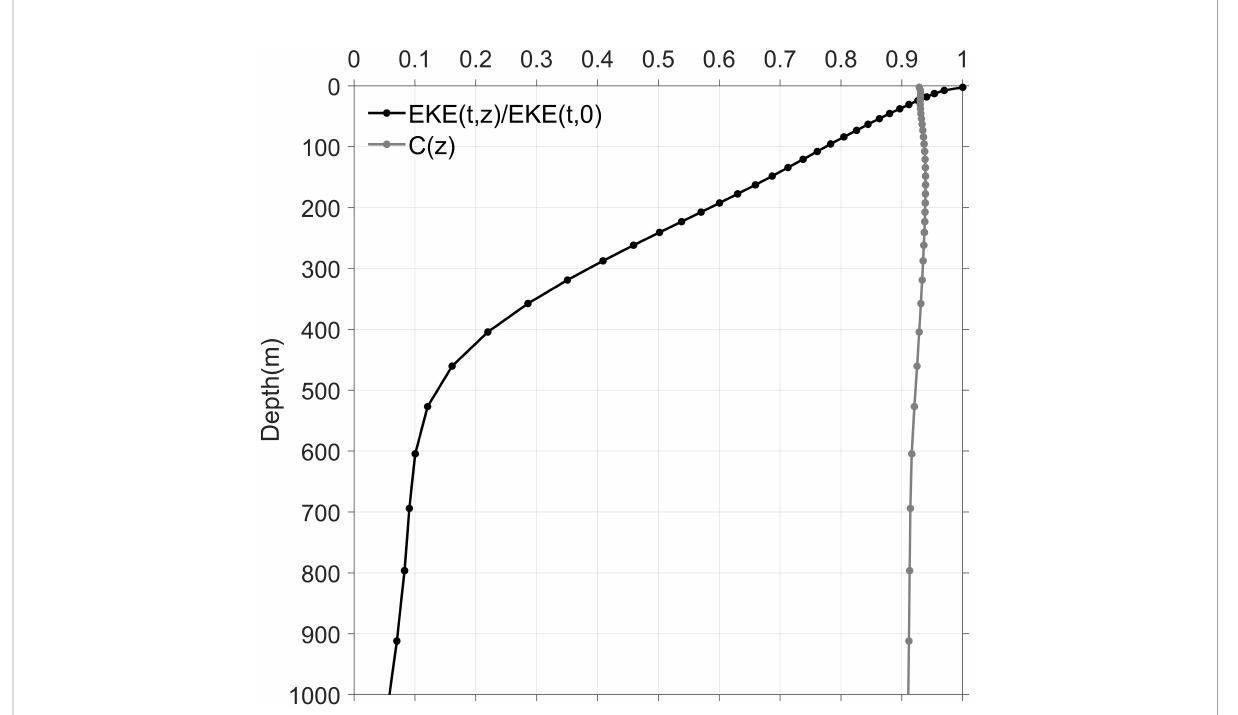
FIGURE 4 Black line: EKE averaged in 148°E-160°E, 30°S-45°S as a function of depth from OFES; the standardized EKE level as a function of depth: E ( t , z ) E Gray line: the EKE coherence level as a function of depth relative to surface EKE: C ( z ), and C ( z ) is de fi ned in Eq. (10).